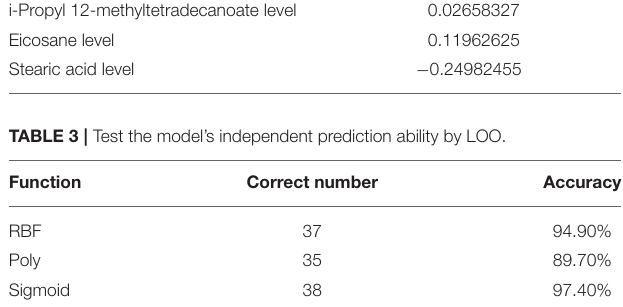
binomial device reached the minimum value. In addition, λ = 0.1800518, that was, log ( λ 1se